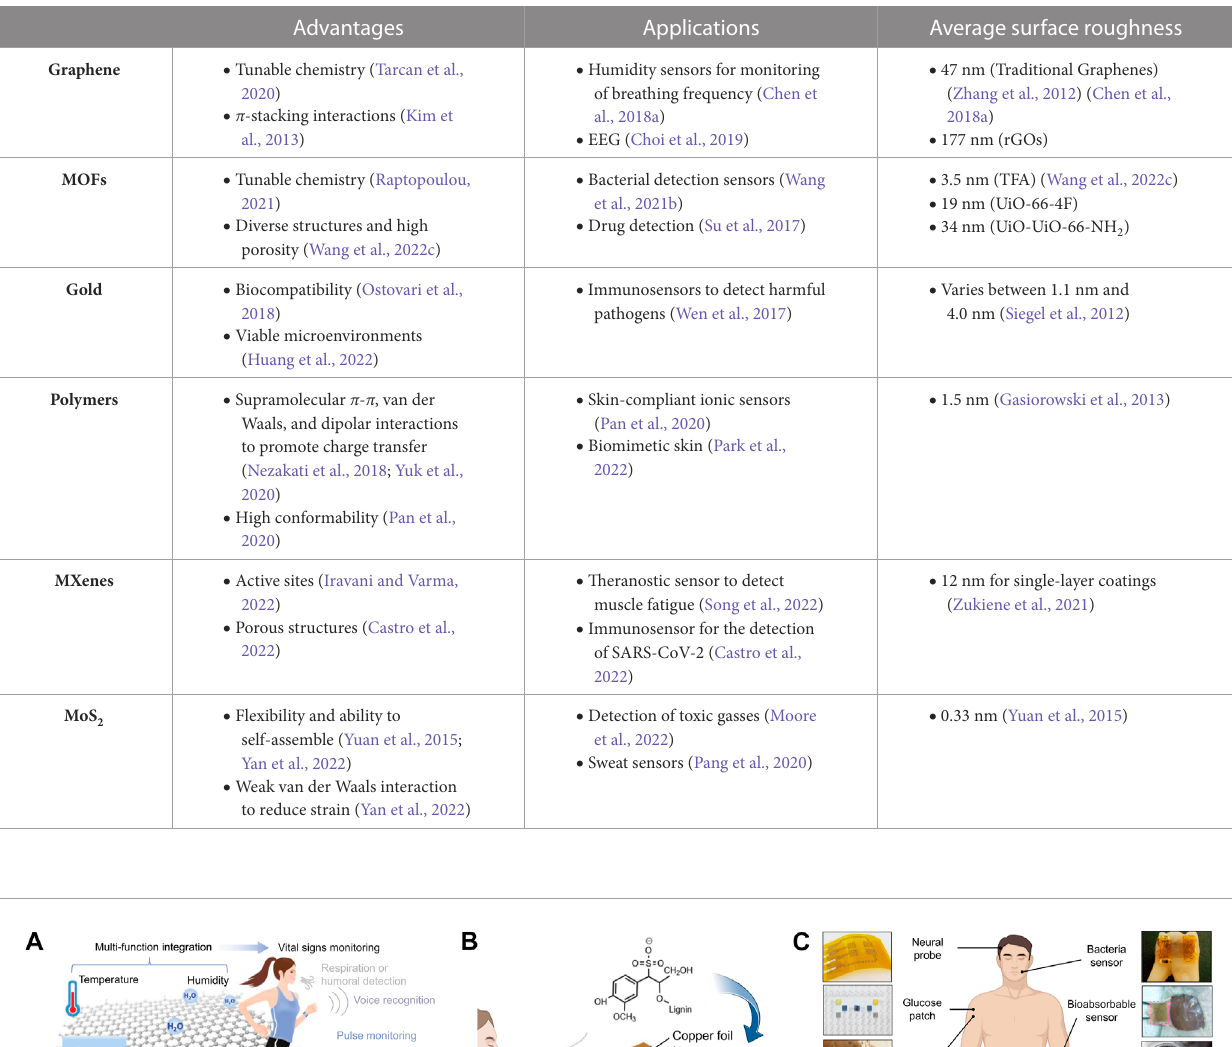
TABLE2 ComparisonofnanomaterialsfortheenhancementofEIS.